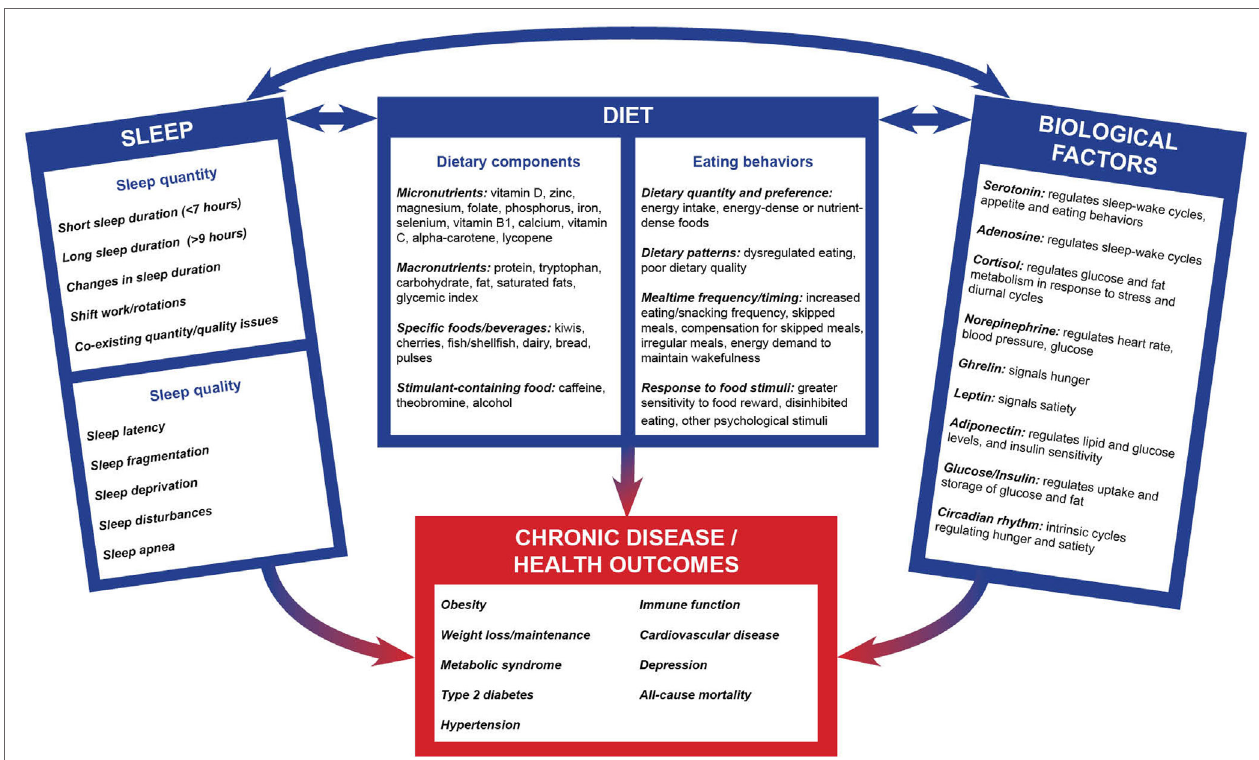
FigURe 1 | Conceptual framework for the interconnections between dietary factors, sleep, and disease. The complex, bidirectional, relationship between sleep components, dietary composition, behavioral factors, and biological factors are theorized to affect the development of chronic diseases and other health outcomes. Intake of nutrients and foods and dietary behaviors are correlated with components of sleep quality and quantity. Dietary components and eating behaviors are regulated by biological factors, which in turn may impact nutritional status. Similarly, sleep quantity and quality result in biological factors being modulated, and these biological factors control sleep factors in return. Dietary components, sleep components, and biological factors have subsequent independent as well as interactive effects on downstream health outcomes. Notably, this multifaceted interaction is evident early in life and continues throughout the life